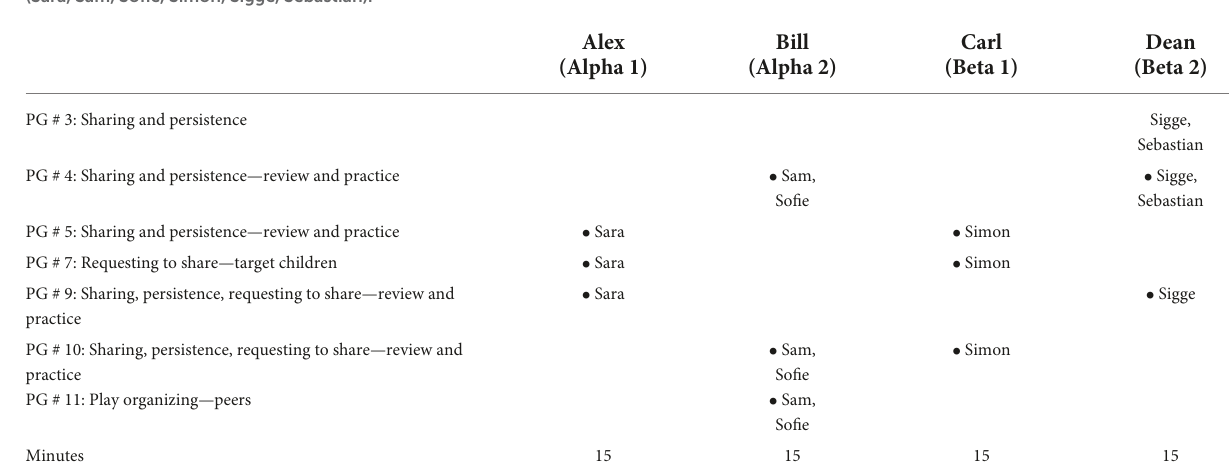
TABLE 3 The sample of analyzed playgroups (PG) with PT/ST learning goals a for children with SEND (Alex, Dean) and SEN (Bill, Carl) and their peers (Sara, Sam, Sofie, Simon, Sigge,